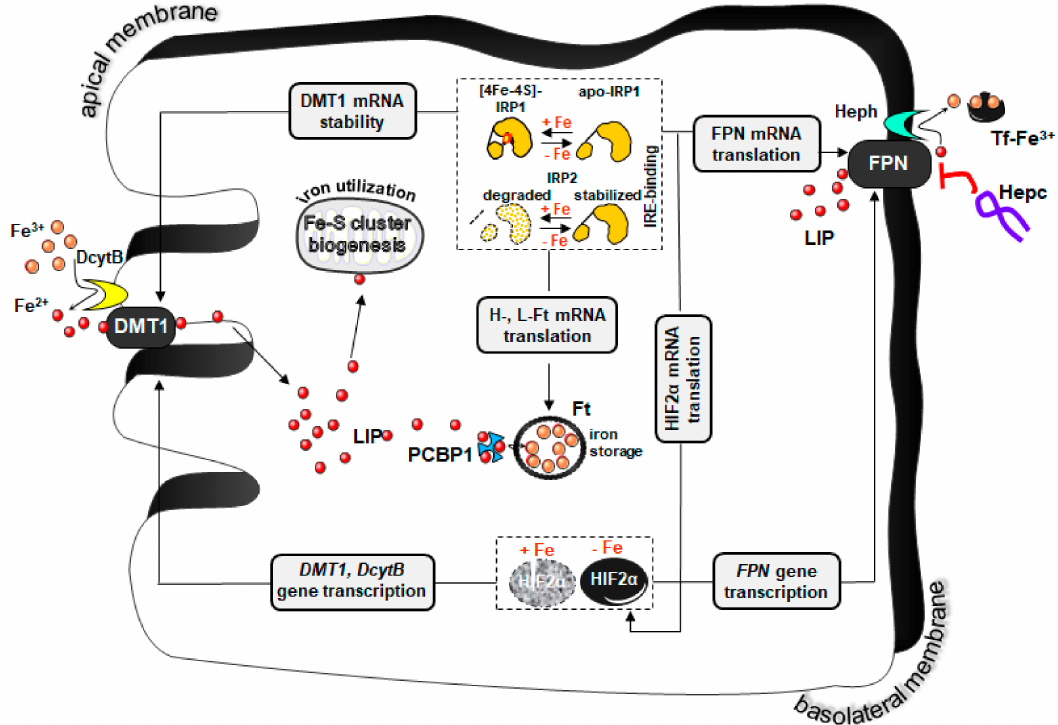
Figure 1. Intestinal uptake of non-heme iron and its regulation. Non-heme iron absorption occurs mainly in duodenal enterocytes. The first step in the transport of iron across the apical membrane of enterocytes is ferric (Fe 3+ ) to ferrous (Fe 2+ ) iron reduction, catalyzed by the membrane-associated ferrireductase duodenal cytochrome B (DcytB). Ferrous iron is subsequently transported into the enterocyte via the divalent metal transporter 1 (DMT1)-dependent pathway. After crossing the apical membrane, iron enters so called labile iron pool (LIP) in the cytosol and is subsequently used for cellular needs (e.g., for iron–sulfur cluster biogenesis in mitochondria), stored inside the cell in ferritin (Ft, which probably requires the chaperone PCBP1 (poly (rC) binding protein 1) to delivers iron to Ft), or exported into the circulation by the iron exporter ferroportin (FPN) present on the basolateral membrane. Iron export from enterocytes also requires hephaestin (Heph), a multi-copper oxidase, which oxidizes Fe 2+ to Fe 3+ , prior to iron binding by transferrin (Tf) in the blood. The expression of genes involved in iron absorption is regulated intracellularly at the level of transcription by